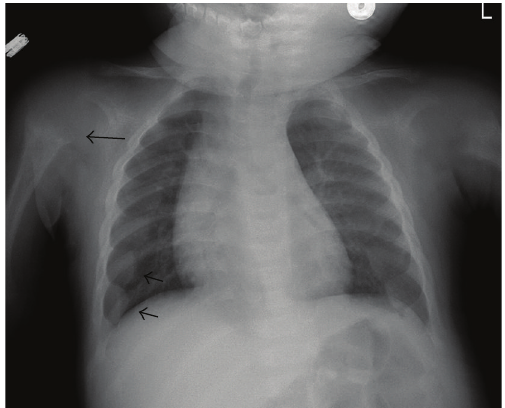
Figure 1: Chest radiograph of an 8-month-old male with fever demonstrating widened anterior ribs (short arrows) and prox- imal humeral metaphyseal fraying and cupping (long arrows). (Reprinted with permission of the American College of Radiology (ACR’s Case in Point, March 20, 2012, Rickets). No other repre- sentation of this material is authorized without expressed, written permission from the American College of Radiology).